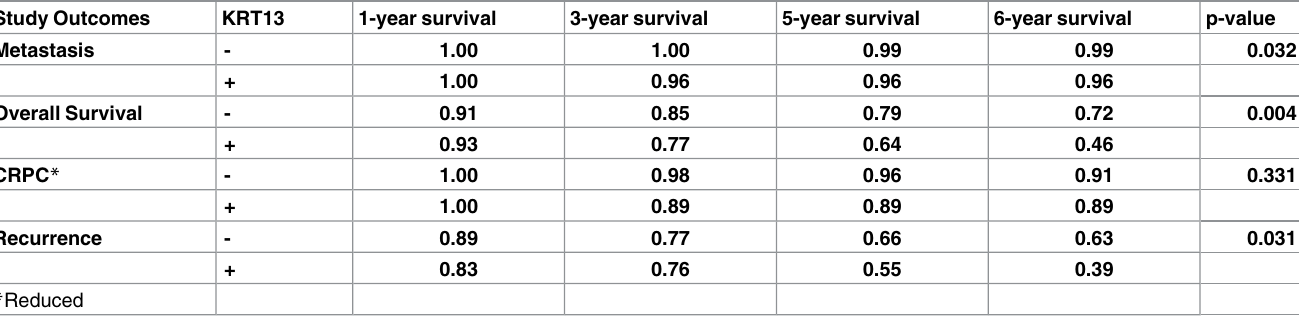
Table 1. Kaplan-Meier Estimated Probabilities for